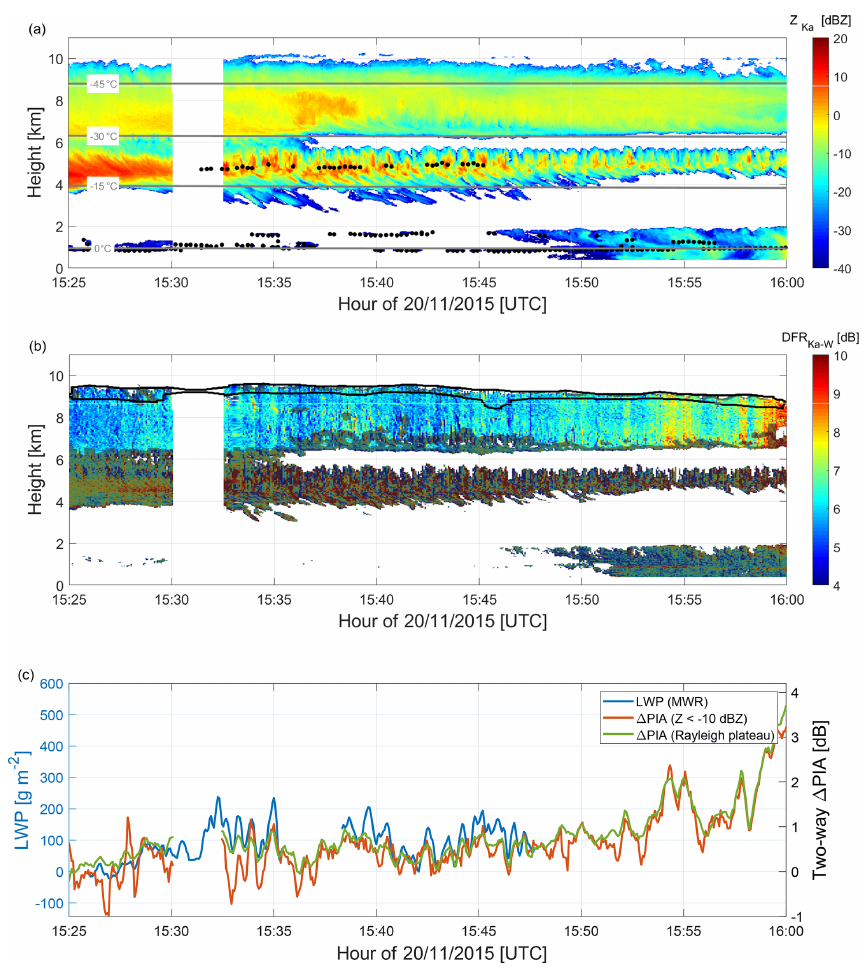
Figure 7. Same as Fig. 5 but for the period between 15:25 and 16:00UTC where a second liquid layer is detected by the ceilometer at around 5km, i.e., at temperatures of between − 15 and − 30 ◦ C. Note that the adjustment of y axis scales follow the same convention as Fig. 5 (i.e., (cid:49) PIA and LWP matching at 0 ◦ C). For the colder temperature of this cloud, the same LWP is expected to produce less attenuation than at 0 ◦ C, as the curves in (c)